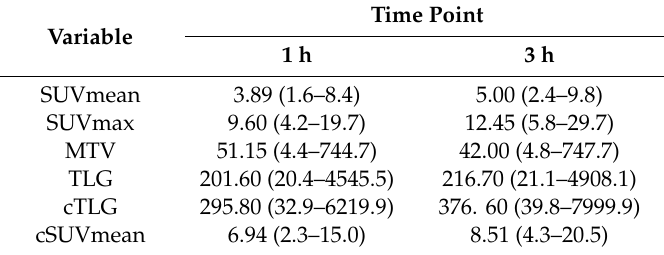
Figure 1. Kaplan–Meier plot for the cohort, including pointwise 95% confidence intervals (analysis time in months). Table 2. Median (range) of the [ 18 F]-fluorodeoxyglucose positron emission tomography measures.